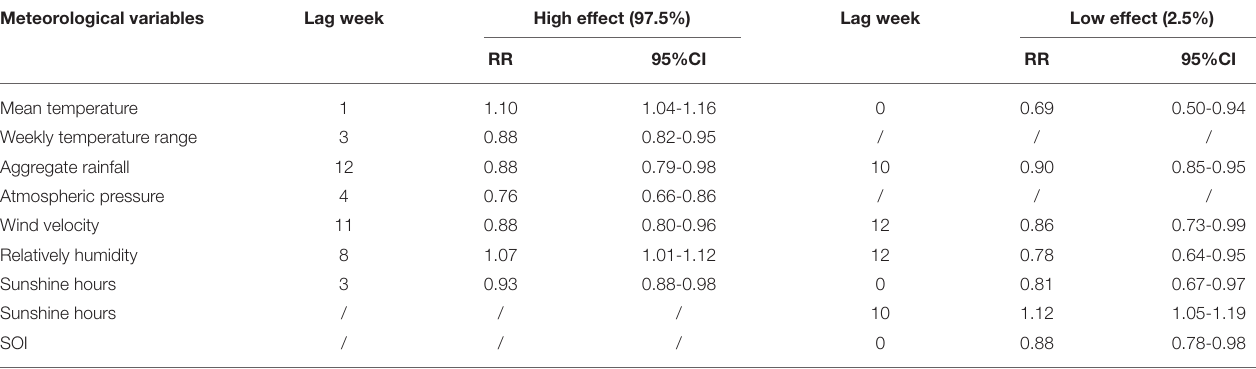
TABLE 2 | The extreme effects of meteorological variables and SOI on scrub typhus along the lag weeks in Guangzhou, Southern China,